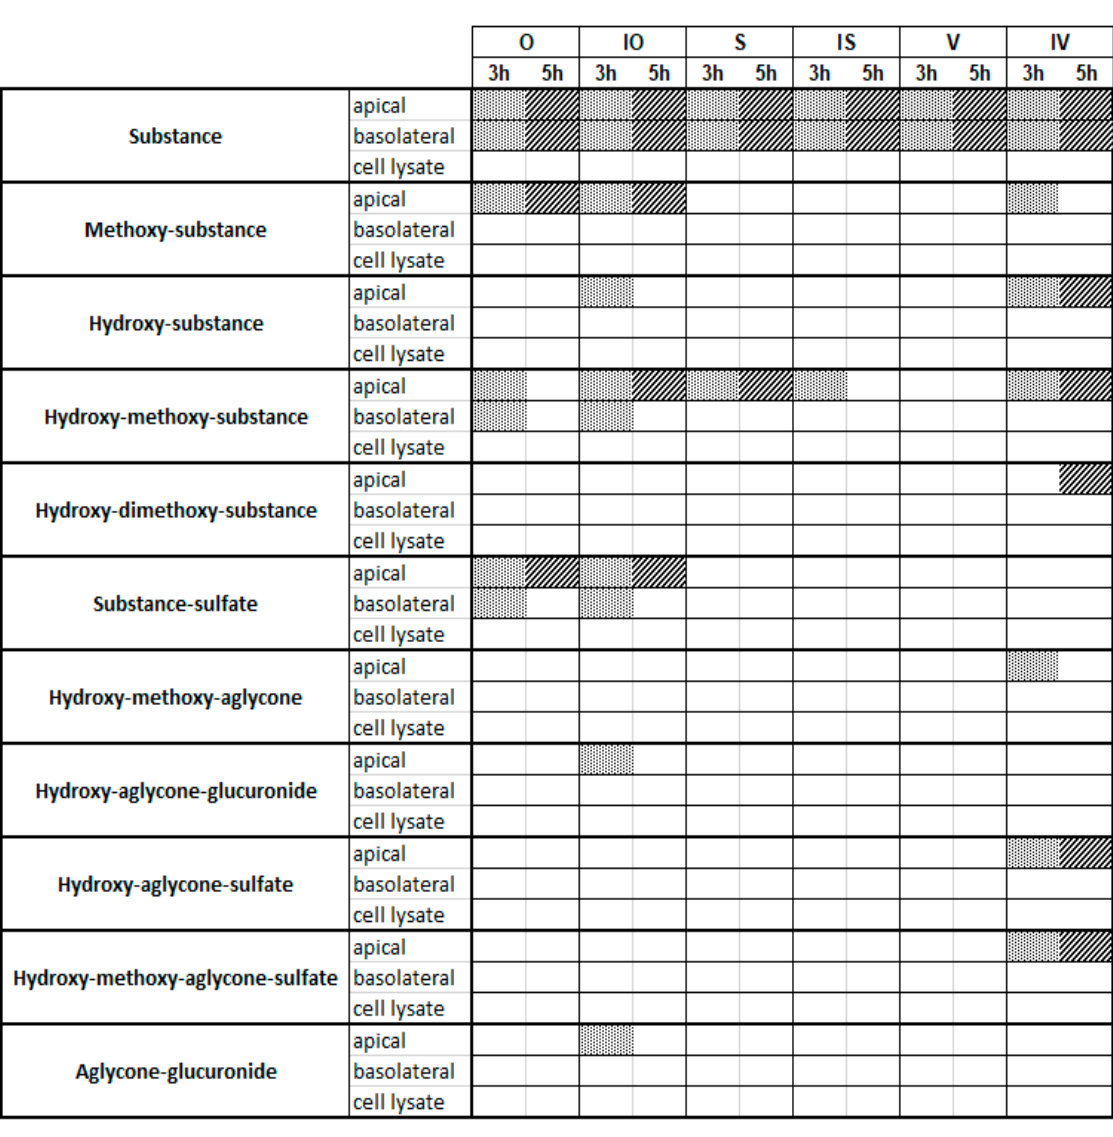
Figure 3. Metabolites detected via UHPLC-MS after a Caco-2 metabolism experiment with 10 µM of the testing substances and incubation times of 3 h and 5 h. Dot line and diagonal line are used for better visualization meaning that the metabolite is detectable.